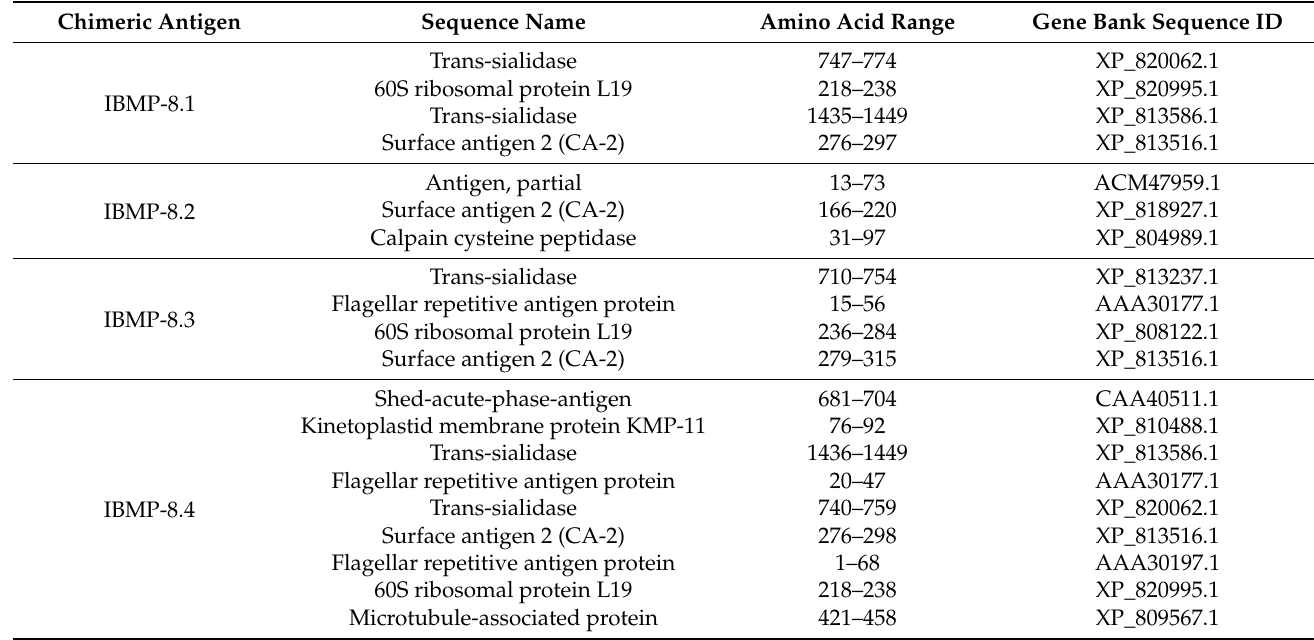
Table 1. Constitution of the IBMP chimeric recombinant proteins.